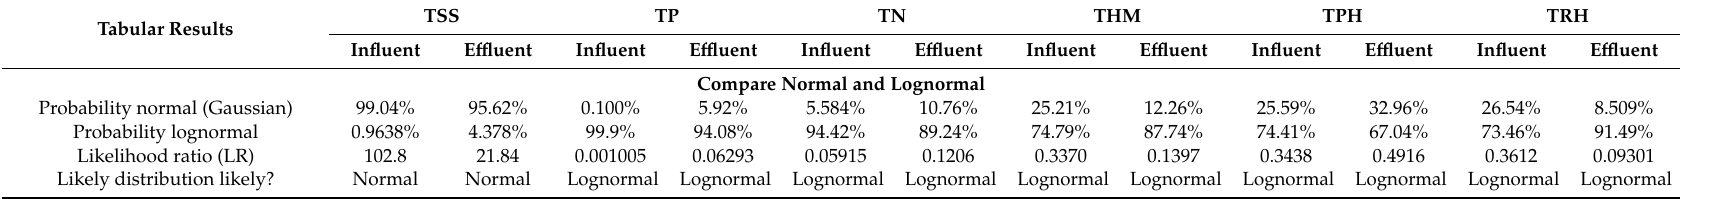
Table 3. Normal and Lognormal distribution test for even mean concentration (EMC) influent and e ffl uent.